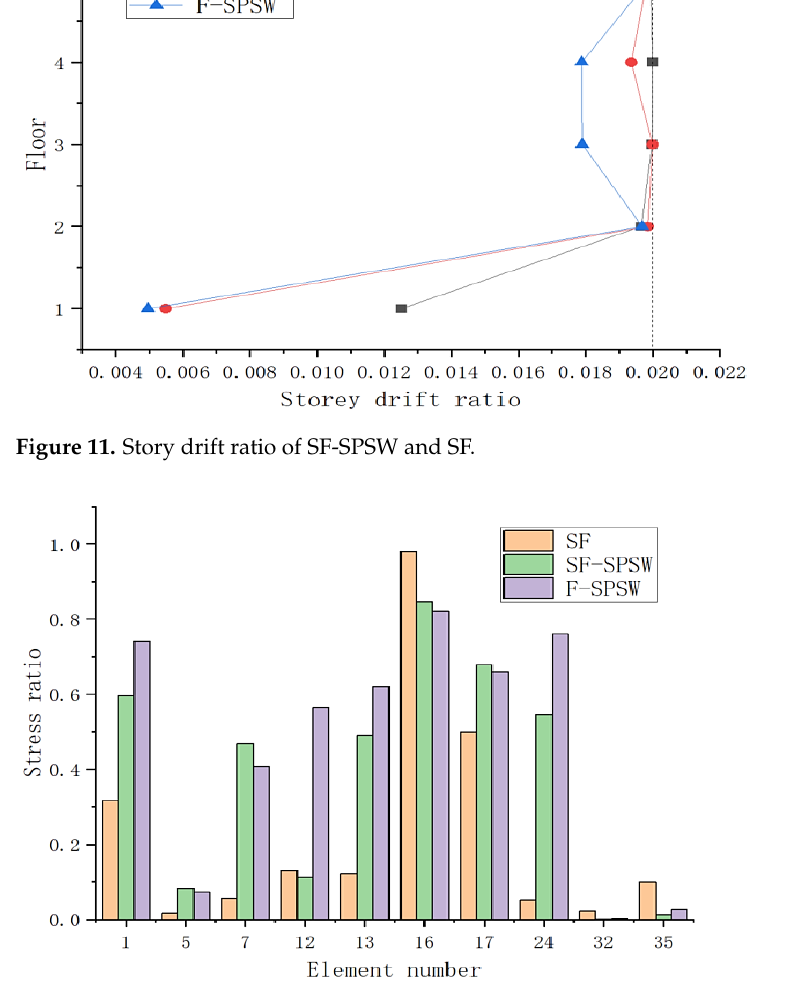
Figure 12. Stress ratio of SF-SPSW and SF. Table 4. The rotation stiffness after optimization.